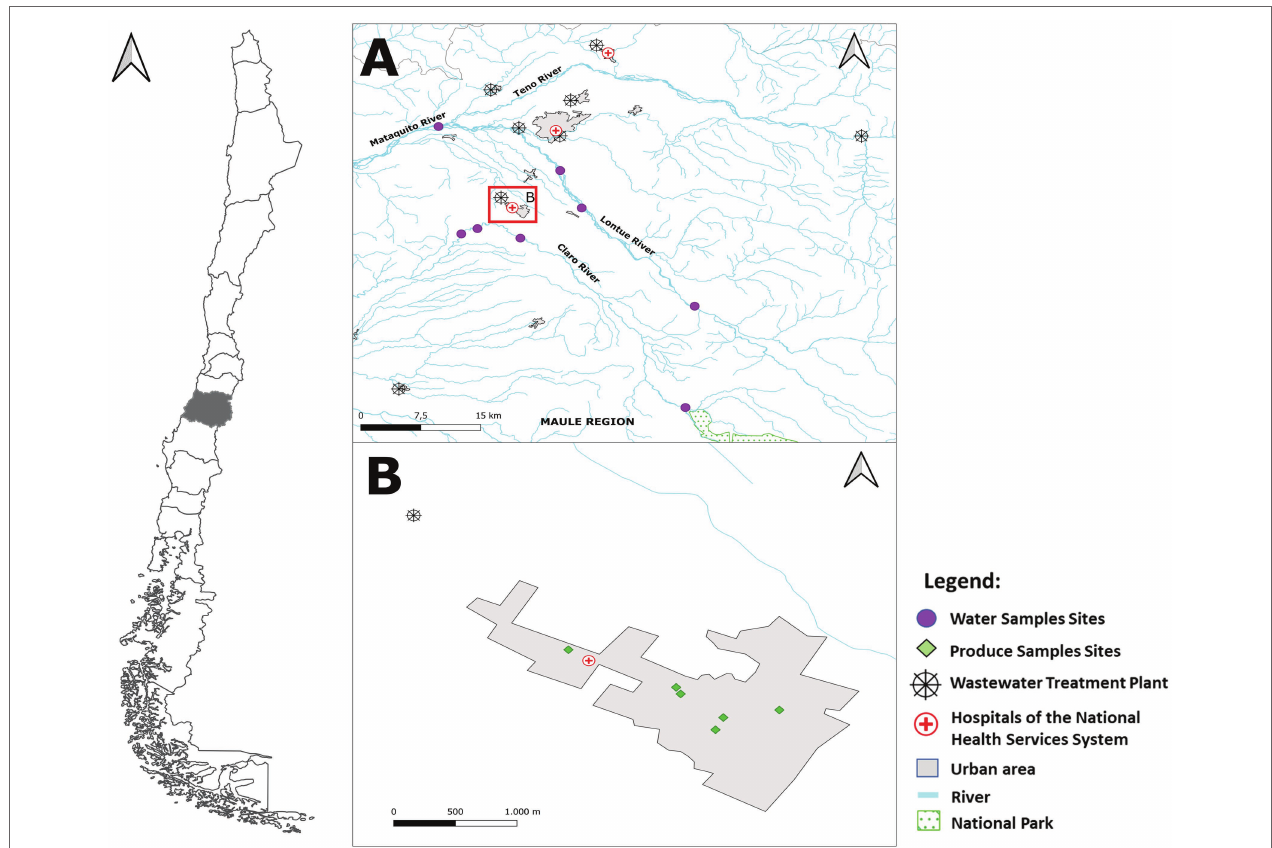
FIGURE 1 | Map of the location of the study. (A) Sampling sites at the two parallel rivers (Claro River and Lontue Basins), (B) sites of the city of Molina in which the five farmer markets were sampled. In the figure, there are six sites for produce sampling because one of the markets moved to another location during the